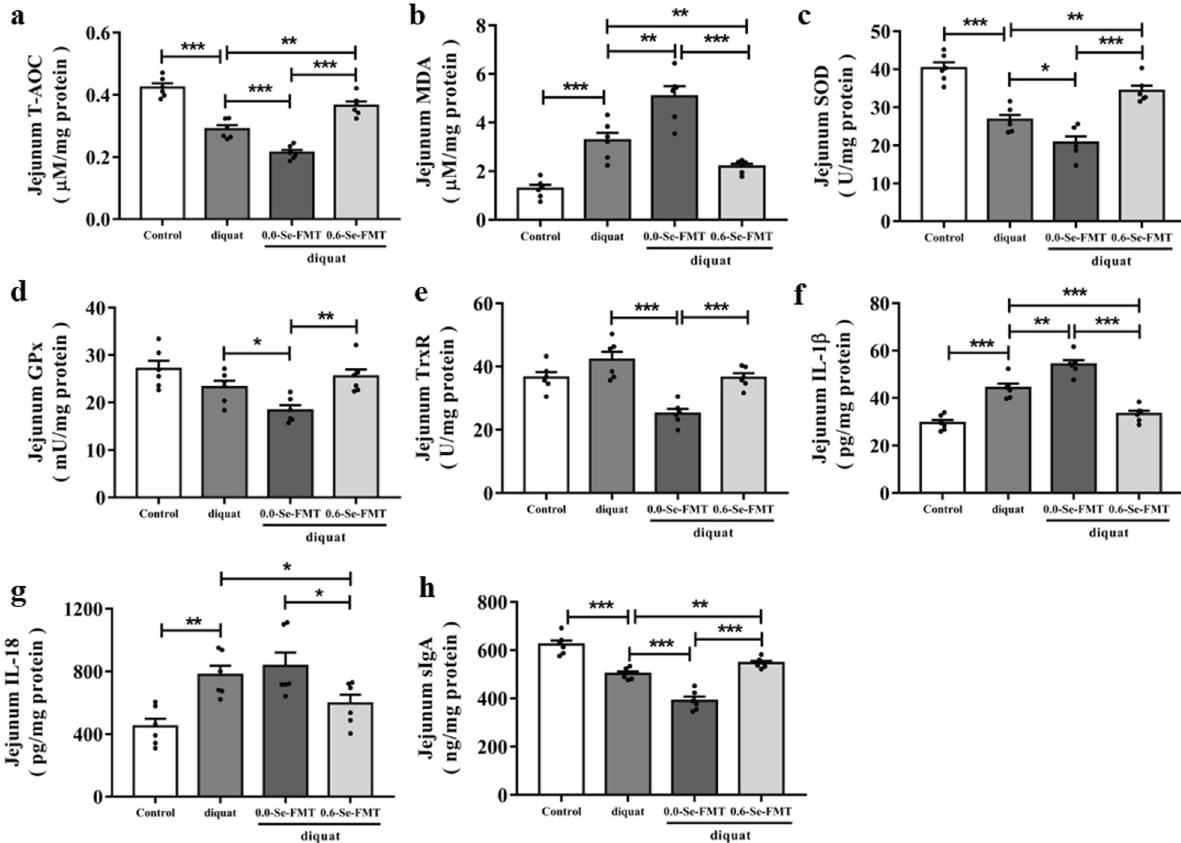
Fig. 8 Effects of FMT on the antioxidant capacity and immune response in mice exposed to diquat. a – e Oxidative stress response markers including T-AOC ( a ), MDA ( b ), SOD ( c ), GPx ( d ), TrxR ( e ) ( n = 6). f Level of IL-1 β in the jejunum of mice ( n = 6). g Level of IL-18 in the jejunum of mice ( n = 6). h Level of sIgA in the jejunum of mice ( n = 6). Data are expressed as mean ± SEM. * P < 0.05; ** P < 0.01; *** P <